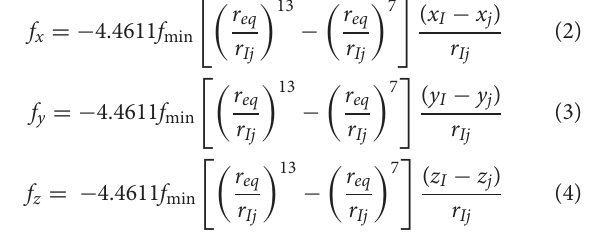
otherwise stated, in a simple cubic arrangement. The undeformed nearest-neighbor distance in the slab is